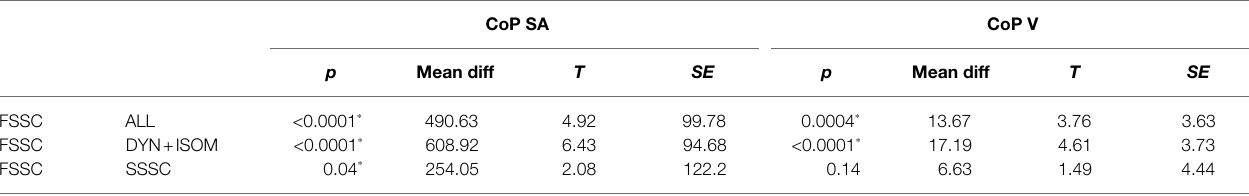
TABLE 4 | Contrast analyses of conditions for the applied balance